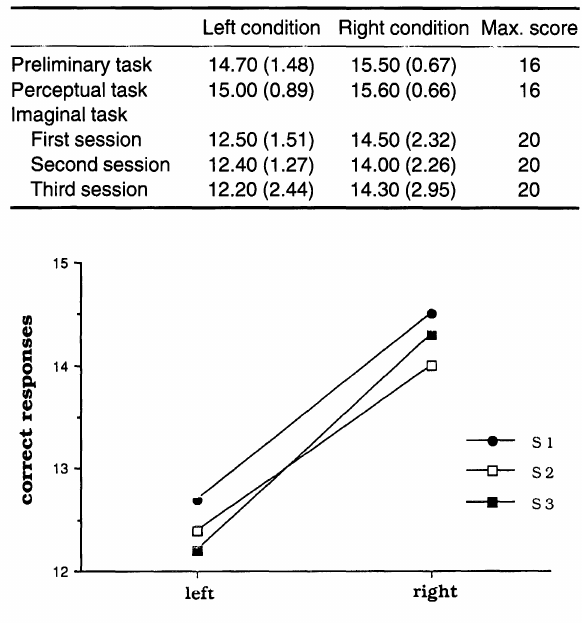
FIG. 1. Mean correct score in imaging the left and the right clock face for the three sessions (S1, S2,